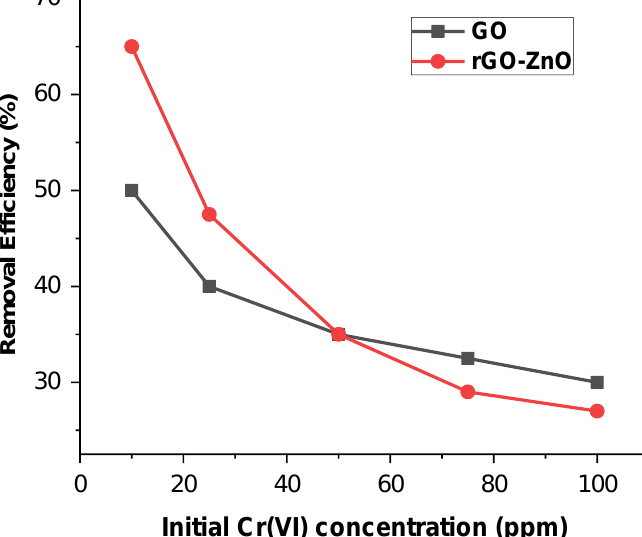
Figure 5. Effect of Cr (VI) concentration on its sorption.